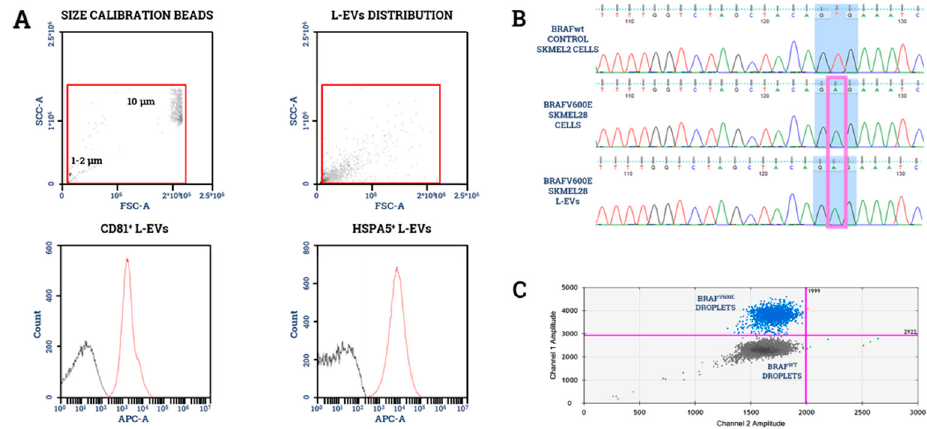
Figure 2. BRAF mutational analysis of L-EV-DNA. Representative BRAFV600E mutational analysis completed on L-EVs isolated by ultracentrifugation from commercial SK-MEL28 melanoma cells. ( A ) As shown, L-EVs were characterized by flow-cytometry for size in relation to their disposition by FW / SSC scatter as well as expression of HSPA5 and CD81. ( B ) Following the DNA extraction, we demonstrated by Sanger sequencing the presence of the BRAFV600E mutation in both SK-Mel28 parental cells and relative L-EVs, as compared to BRAF wild type control cells (SK-MEL2). The triplet referred to the V600 position is shaded in blue, while the mutated base is contained in the purple box. ( C ) Similar findings on SK-MEL28 derived L-EVs were also obtained using the droplet digital-PCR. Blue dots represent the BRAFV 600E droplets, while gray dots represent the BRAF WT